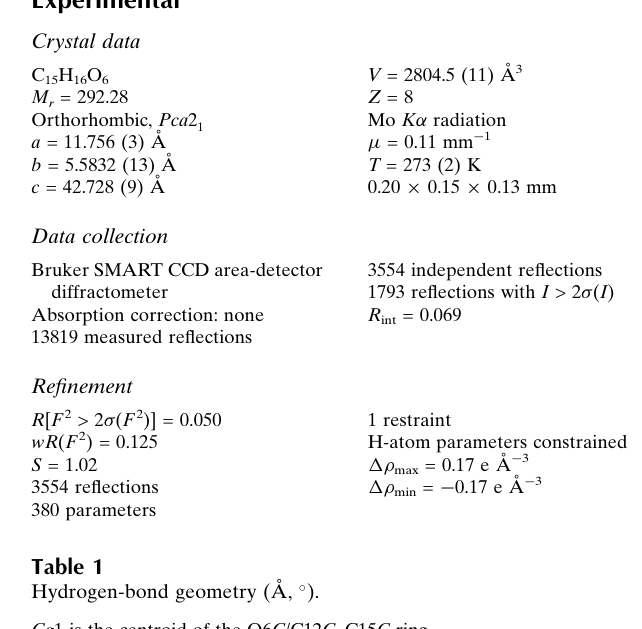
Hydrogen-bond geometry (A˚ , (cid:1)